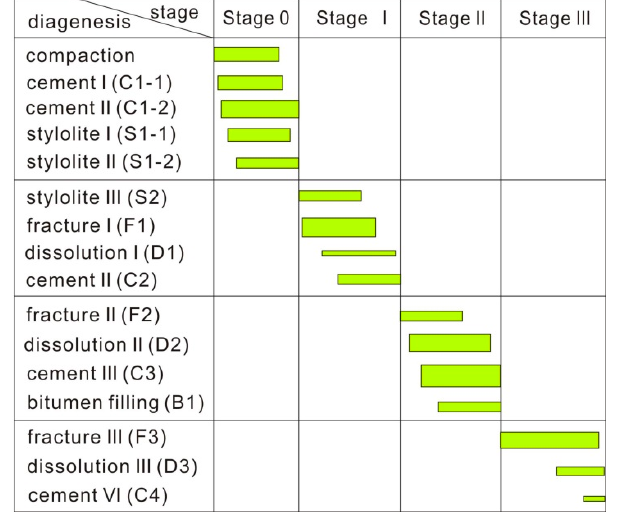
Figure 9. Paragenetic sequences of diagenesis affecting the Ordovician carbonate rocks in the fault damage zones of the Halahatang area. The length and height of each green bar is representative of the relative duration and magnitude of event, respectively. The diagenetic sequences from stage 0 are those that likely to have occurred early, during burial and compaction (i.e., an eodiagenetic setting) prior to the onset of fault activity. Some stylolites (S1-2) with small dip angles to bedding possible indicate the initiation of fault activity. Stages Ⅰ - Ⅲ possibly correspond to the fault activities occurring during the Late Ordovician, Permian and Cenozoic eras (Figure 2a) [29,30].